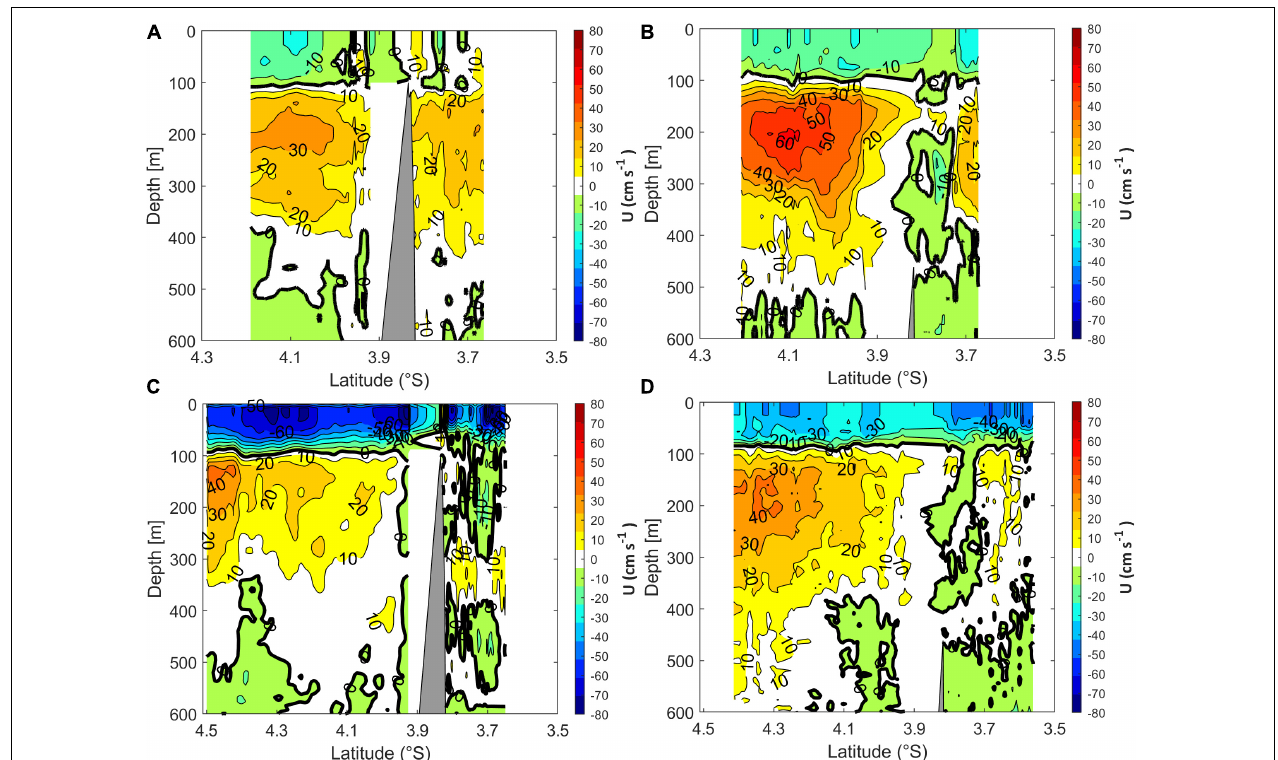
FIGURE 11 | Zonal velocity component (in cm s − 1 , 0–600 m depth) near FN in the western (left side, see Tb transects in Figure 2 ) and eastern (right side, see Tc transects in Figure 2 ) regions, during spring 2015 (A,B) and fall 2017 (C,D) . The contour interval is 10 cm s − 1 . The transects (Tb and Tc) are not along a single straight line, but along two non-meridional line segments.